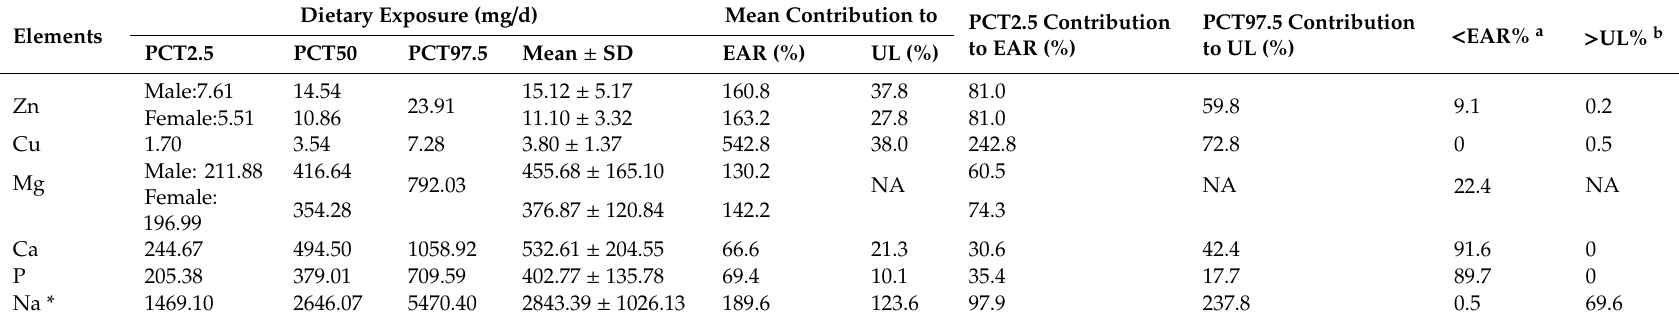
Table 5. Estimated dietary intakes of zinc (Zn), copper (Cu), magnesium (Mg), calcium (Ca), phosphorus (P), and sodium (Na) in adult population ( n = 438, 199 males and 239 females) in Shiraz, Iran and comparison with guidance